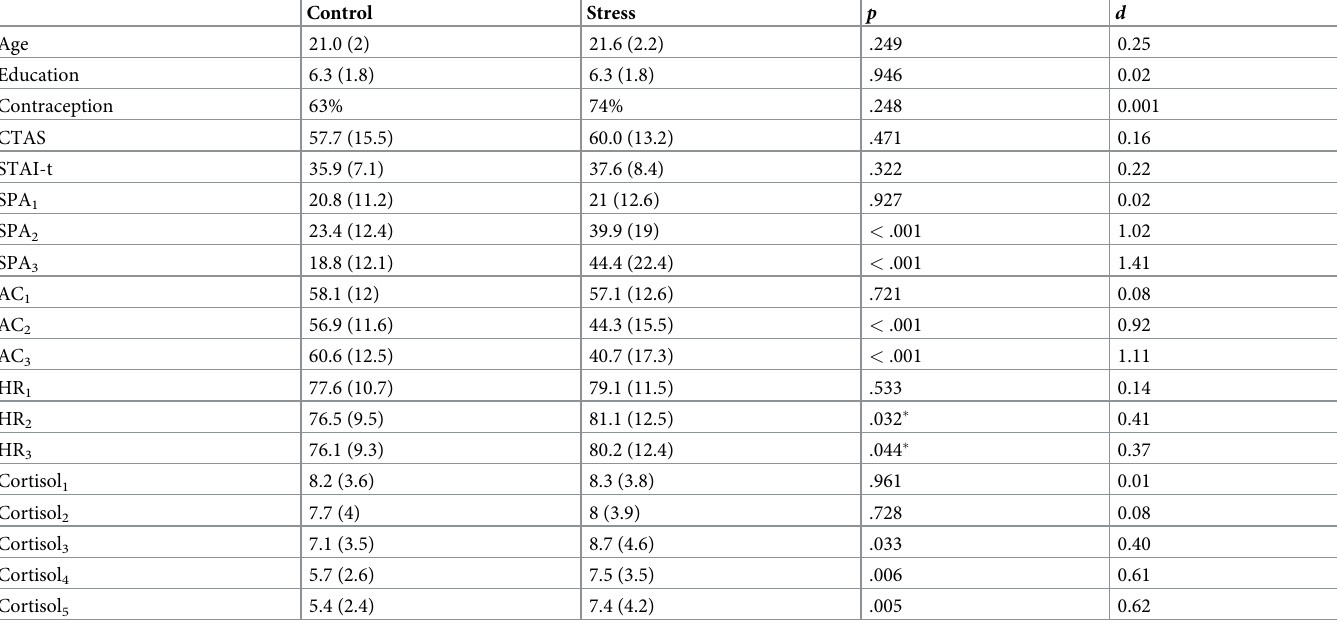
Table 1. Means (and standard deviations) and t-tests of background characteristics, and self-report and objective measurements of stress for the control ( n = 41) and the stress group ( n = 45).